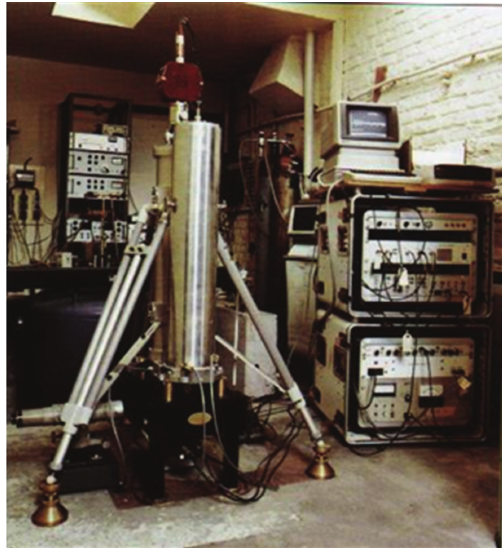
Figure 6: AXIS FG5 absolute